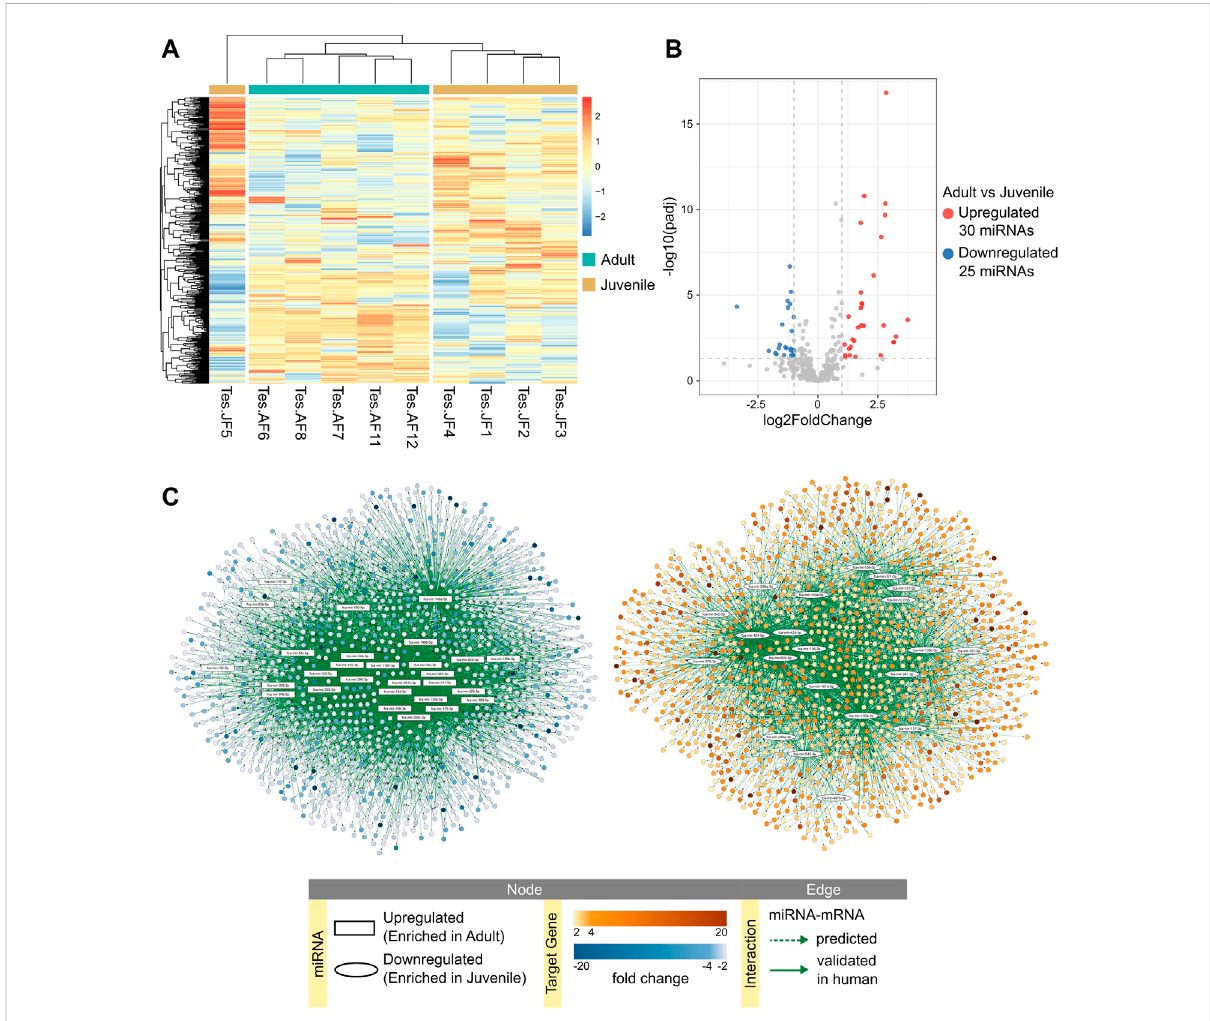
FIGURE 3 miRNA expression in adult and juvenile testicular tissues. (A) Heatmap of one-way hierarchical clustering analysis (Euclidian method, complete linkage) using Z-score for RLE normalized values of all mature miRNAs identi fi ed in adult and juvenile testes. (B) Volcano plot showing differentially expressed mature miRNAs in adult vs. juvenile testes (Wald test, adjusted p -value < 0.05, absolute fold change ≥ 2). (C) miRNA-mRNA predicted interaction networks enriched in adult or juvenile testes. Full size interactive networks with corresponding data tables are available in Supplementary Data Sheet